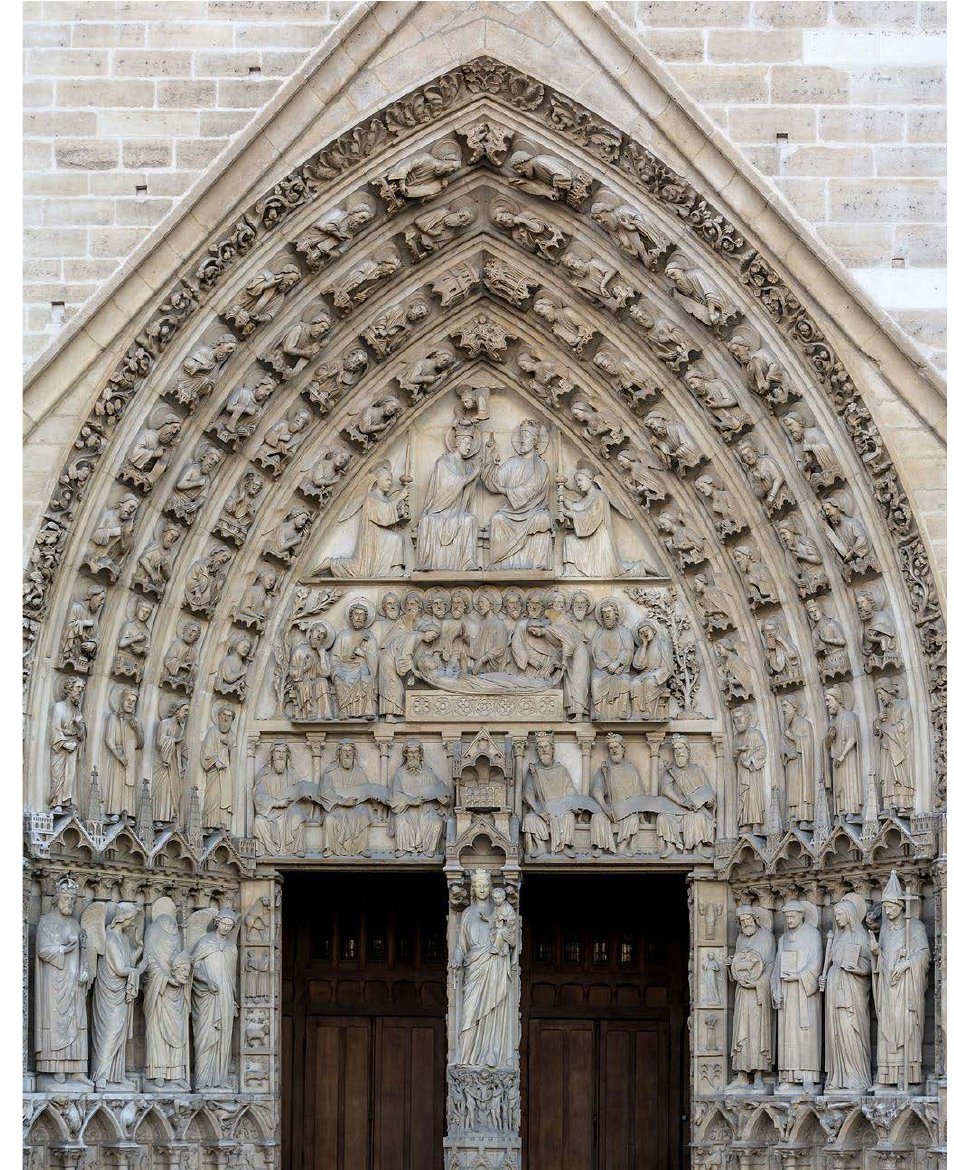
Figure 5. Notre-Dame of Paris Cathedral. Portal of the Virgin , North bay of the West façade, c. 1210–20.